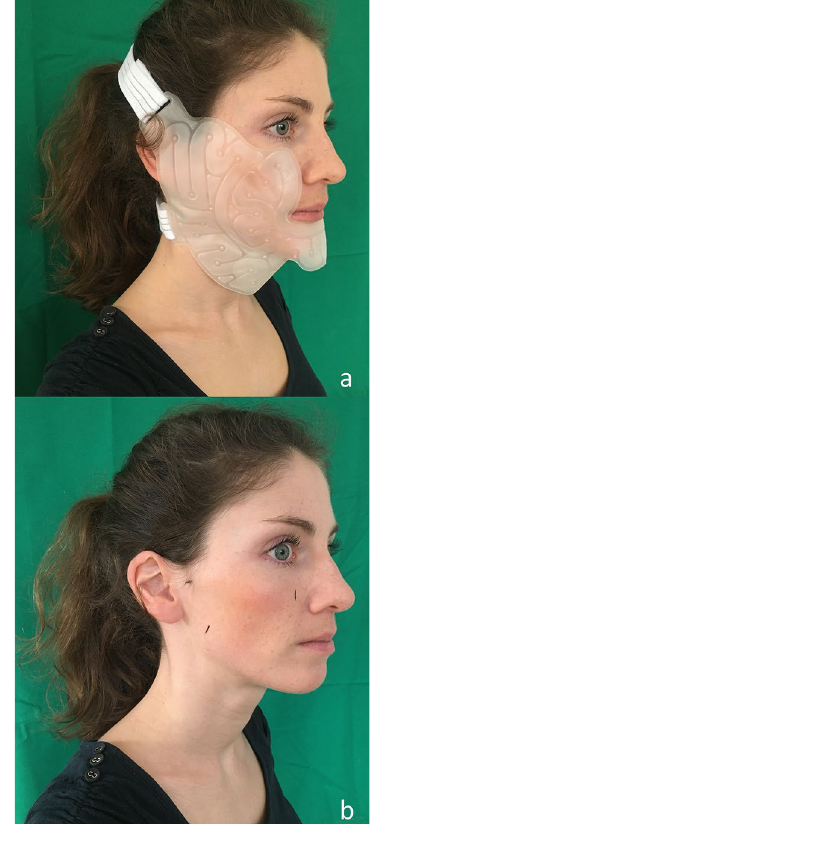
Figure 1. ( a ) Hilotherm cooling mask fixed on volunteer. ( b ) Measuring points marked to volunteer’s